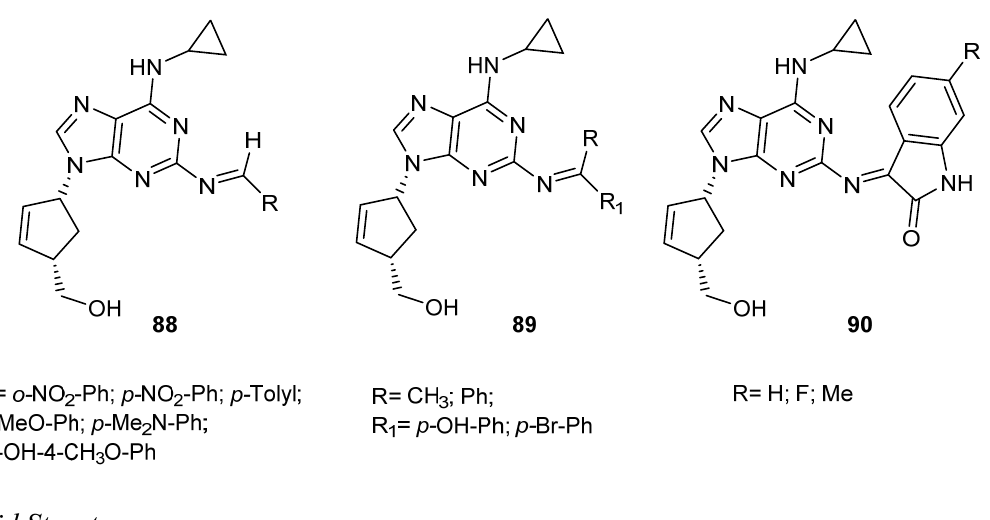
Figure 12. Schiff bases of